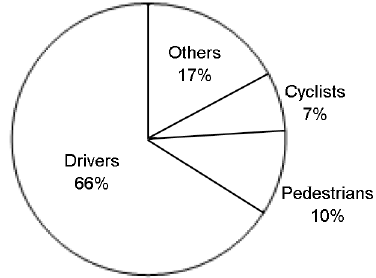
Fig. 4. The percent distribution of traffic accident guilty parties in Lithuania in 2011 (total number of registered accidents –